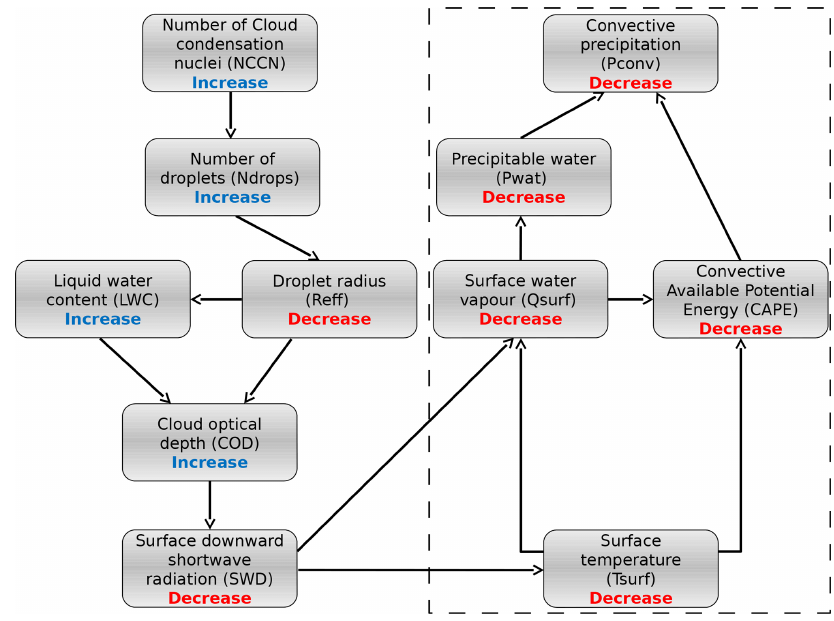
Figure 1. Schematic summary of the aerosol causal sequence for the indirect effects of aerosols on convective precipitation (adapted from Da Silva et al., 2018). The dotted rectangle indicates the part of the scheme which is detailed in the present study.